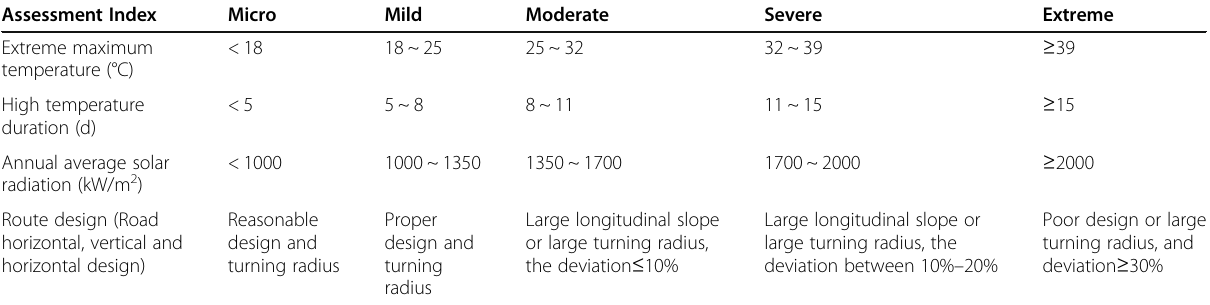
Table 3 Assessment standard of extreme high temperature climate in cold regions